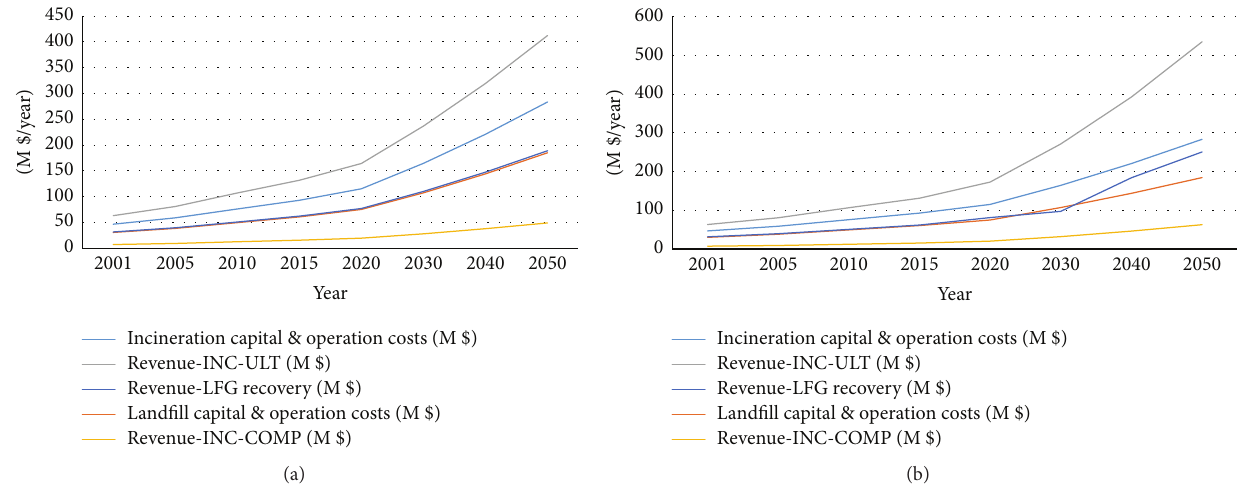
Figure 7: Economic analysis (actual and projected) for LFG recovery system and waste incineration in Dhaka and Chittagong from year 2000 to year 2050. Carbon credit and electricity sales summed as revenue. (a) represents the projection using historical MSW generation rate and (b) represents the projection using CAGR approach. Table 8: Scenario description for the WtE option in Dhaka and Chittagong, Bangladesh.